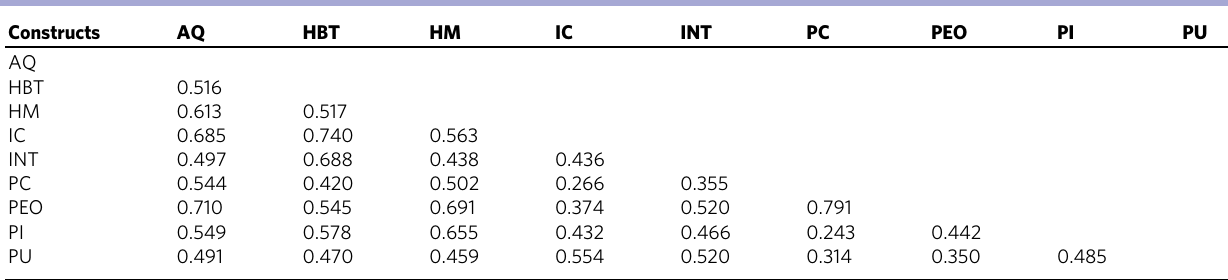
Table 2 Discriminant validity: Heterotrait-Monotrait ratio analysis